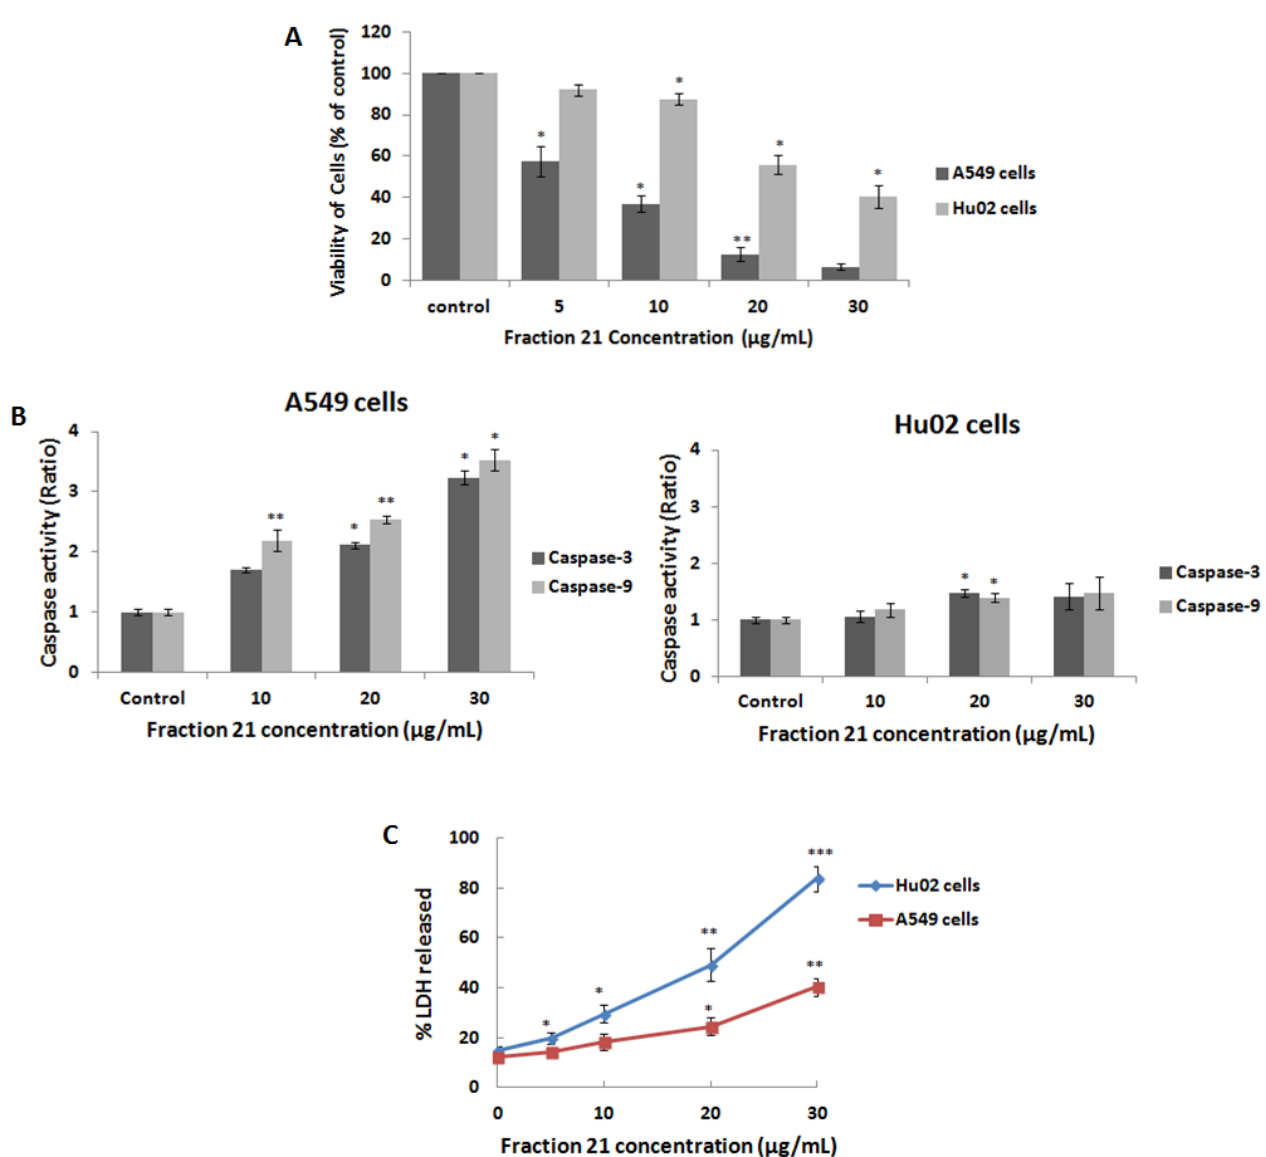
Figure 5. Analysis of cell viability and caspase-3 and caspase-9 activities after treatment of A549 and Hu02 cells with different concentrations of fraction 21 of P. persicus venom. ( A ) The dose-dependent effect of fraction 21 on the cell viability of A549 and Hu02 cell lines. ( B ) The caspase-3 and caspase-9 activities of the A549 and Hu02 cells after treatment with different concentrations of fraction 21. Relative caspase-3 and caspase-9 activities were estimated as a ratio of the cells treated with fraction 21 to untreated cell (control). ( C ) Effects of different concentrations of fraction 21 on the percentage of LDH released in A549 and Hu02 cells 24 hours after incubation. All data were presented as mean ± S.D (n = 3). Statistical significance versus control (*p < 0.05; **p < 0.01; ***p <